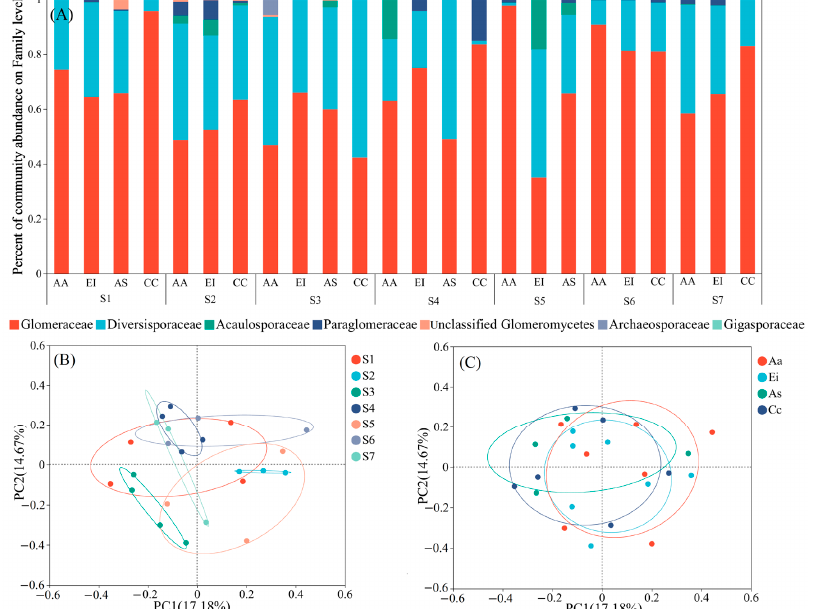
Figure 2. Relative abundances of reads of detected families of Glomeromycota in all sampling sites ( A ) and principal coordinates analysis (PCoA) plots of communities of arbuscular mycorrhizal fungi (AMF) across the four sampling sites based on the Bray–Curtis method with different sampling sites ( B ) (R = 0.305, p = 0.003) and different plants ( C ) (R = 0.037, p = 0.693) as the basis for classification. Aa: Artemisia argyi , Ei: Eleusine indica , As: Astragalus sinicus , and Cc: Conyza canadensis .